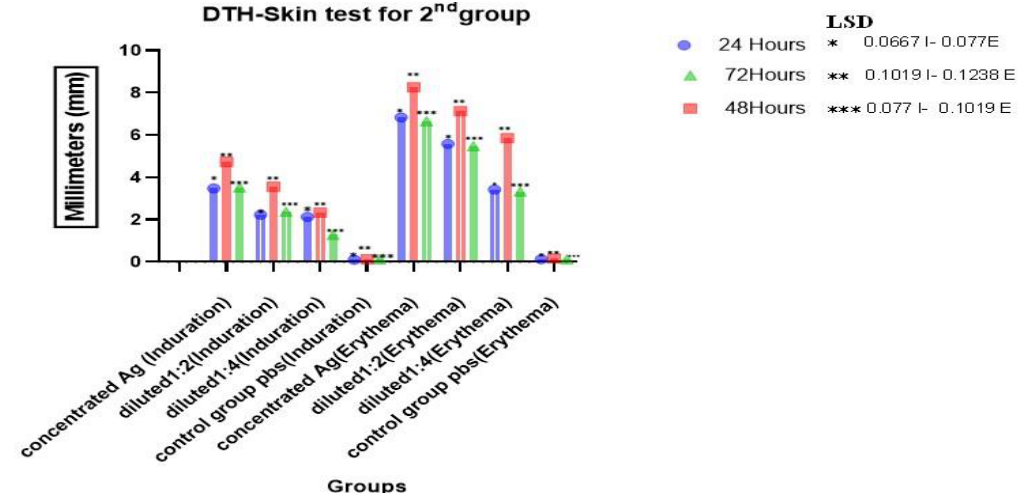
Figure 3. DTH test induration and erythema of rabbits immunized by